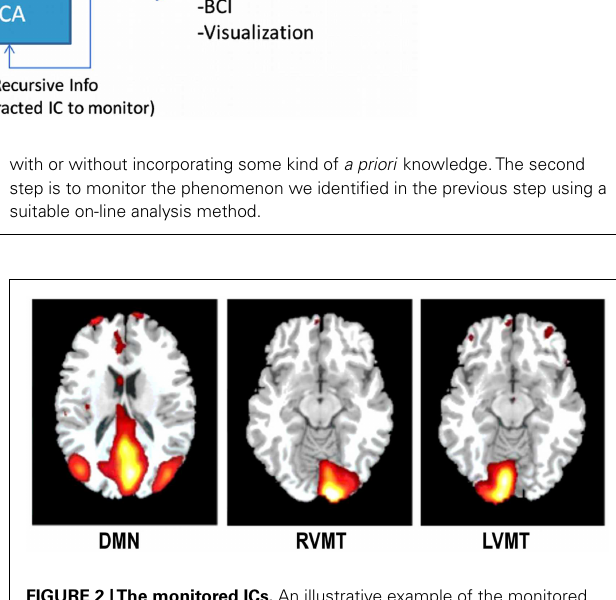
FIGURE 2 |The monitored ICs. An illustrative example of the monitored ICs is reported. Spatial maps of ICs considered in the simulation are obtained from Group ICA 20 ICs. For ease of visualization only the relevant slices are reported here. First column depicts Default Mode Network (DMN). Second and third columns depict the two task related ICs, Right Visuo-MotorTask (RVMT) and LeftVisuo-MotorTask